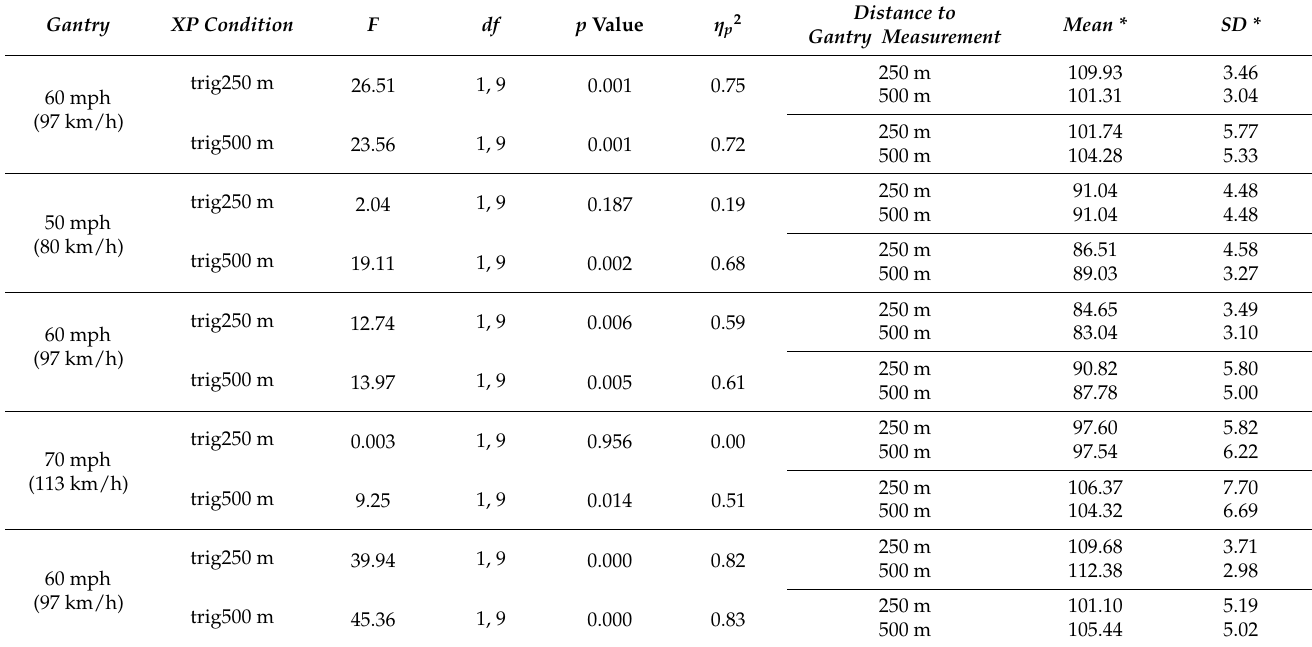
Table 4. Repeated measures ANOVA conducted to compare mean speeds at 250 m and 500 before the overhead gantry, within both experimental